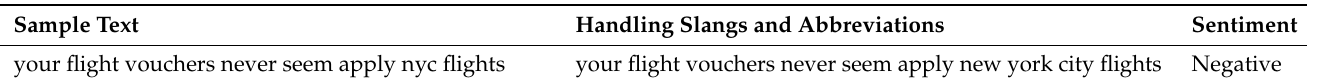
Table 10. Outcome after dealing with abbreviations and slangs.